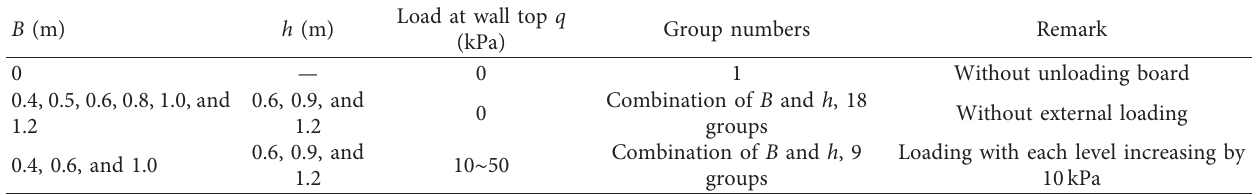
Table 4: The comparison of measured deformation of rib pillars’ top and numerical calculated